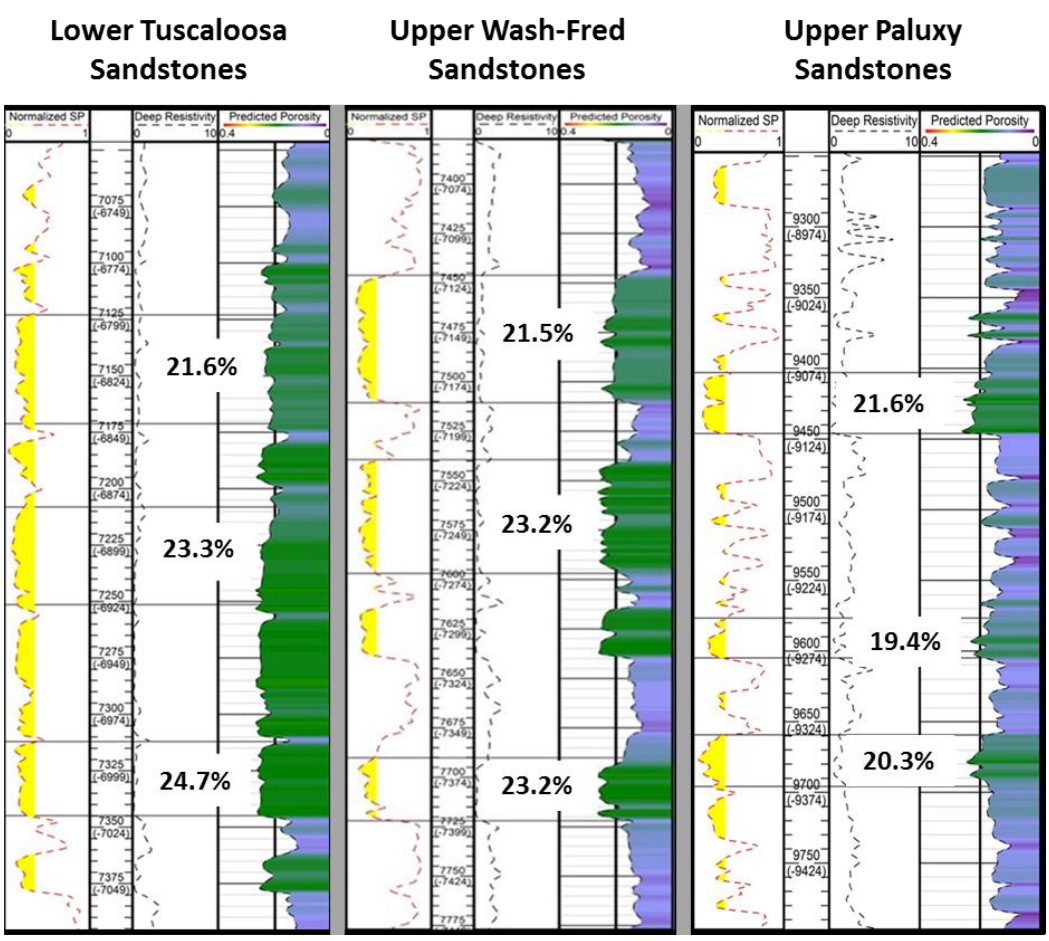
Figure 9. An example of synthetic porosity curves from well A-34-6 #1 located several miles west of the three well pairs that were used to train and validate the neural network. Source: Author Conception. Synthetic porosity curves generated in MatLab® and displayed using Petra® .